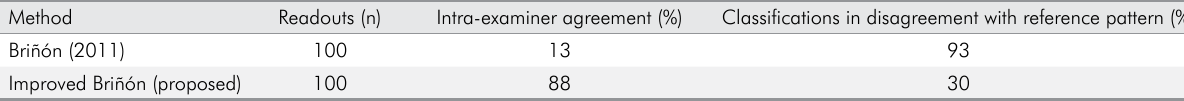
Table 1. Reproducibility of rugoscopic methods and classification of intra-examiner agreement.